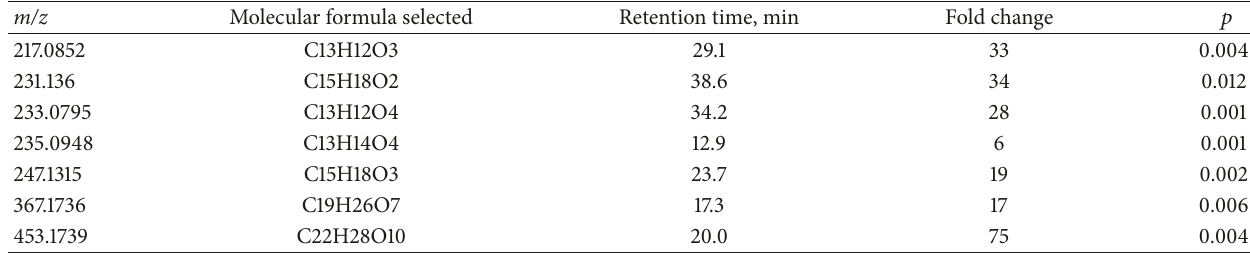
Table 1: Precursors list and the accepted molecular formulas.